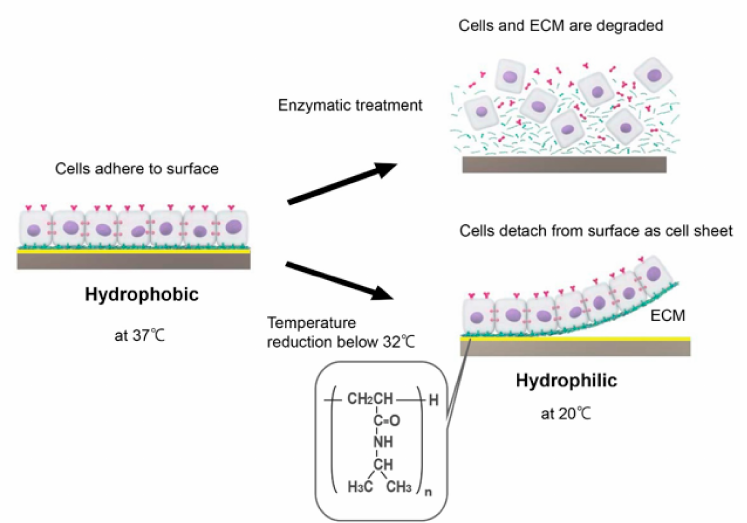
Figure 2. Generation of a cell sheet on a temperature-responsive surface. The temperature-responsive dish allows cultured cells to be harvested as an intact, confluent sheet simply by lowering the temperature (culture in a CO 2 incubator set at 20 ◦ C). This technique prevents the need for enzymatic harvesting. The schematic diagram was drawn with the graphic design software, Adobe